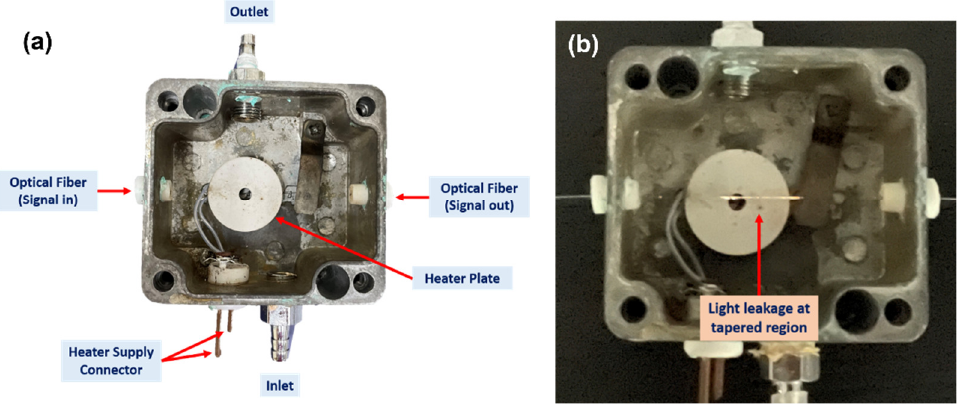
Figure 7. ( a ) Gas chamber for optical fiber and ( b ) light propagates into the tapered optical fiber